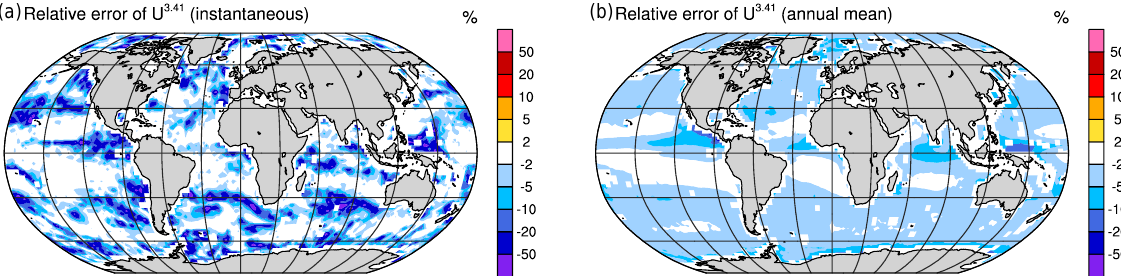
Figure 3. Relative error of U 3 . 41 over the ocean, caused by ignoring sub-grid wind variability. The quantity shown is the relative error of 10 Eq. (10) with respect to Eq. (11), calculated on an imagined 2 ◦ × 2 ◦ horizontal grid using the ECMWF 15km global analysis. Left panel shows the instantaneous results at an arbitrarily chosen time (00:00GMT on 1 January 2011). Right panel shows the relative error of the year 2011 annual mean.